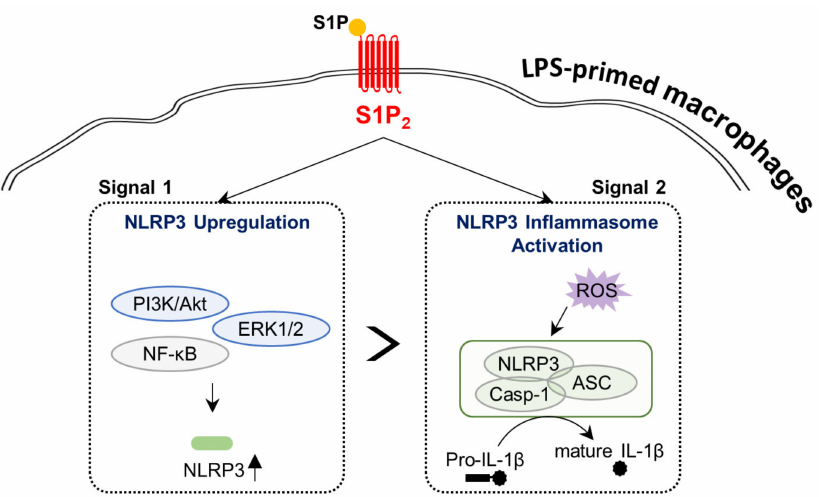
Figure 9. Schematic diagram describing the regulation of the activation of NLRP3 inflammasome by the S1P/S1P 2 signaling axis in BMDMs. S1P contributes to both NLRP3 upregulation (Signal 1) and NLRP3 inflammasome activation (Signal 2; ASC speck formation, caspase-1 activation, IL-1 β maturation, and IL-1 β secretion) in BMDMs only when cells were primed with LPS. S1P 2 plays a pivotal role in such S1P-driven NLRP3 upregulation and NLRP3 inflammasome activation in LPS-primed BMDMs. The S1P/S1P 2 signaling axis regulates the activation of NF- κ B, PI3K/Akt, and ERK1/2 in NLRP3 upregulation. In addition, the S1P/S1P 2 signaling axis regulates ROS production in NLRP3 inflammasome